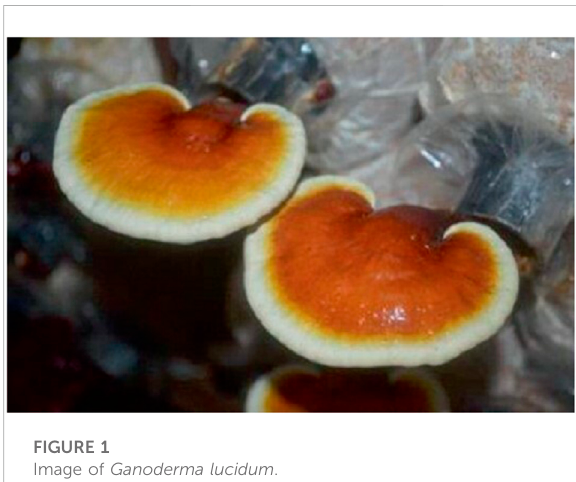
FIGURE 1 Image of Ganoderma lucidum